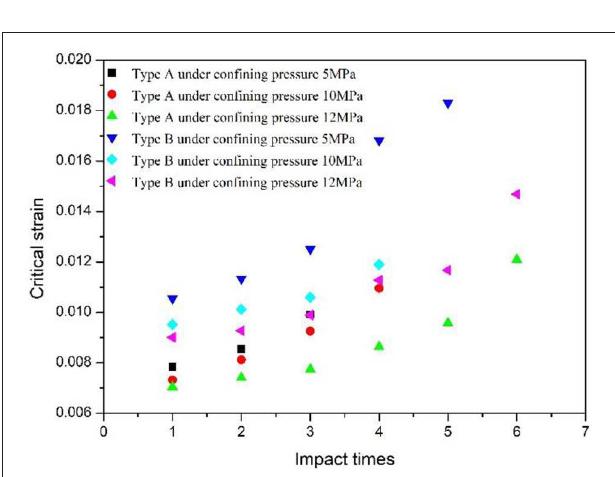
FIGURE 9 | Variation in cumulative absorption energy with respect to impact